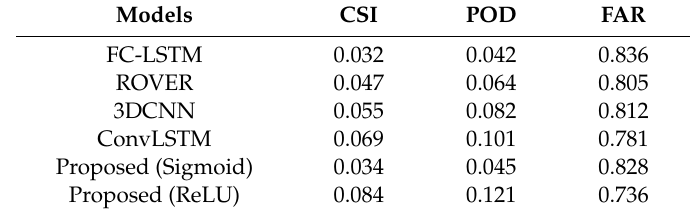
Table 5. Performance comparison of di ff erent models of the 40dBZ threshold.